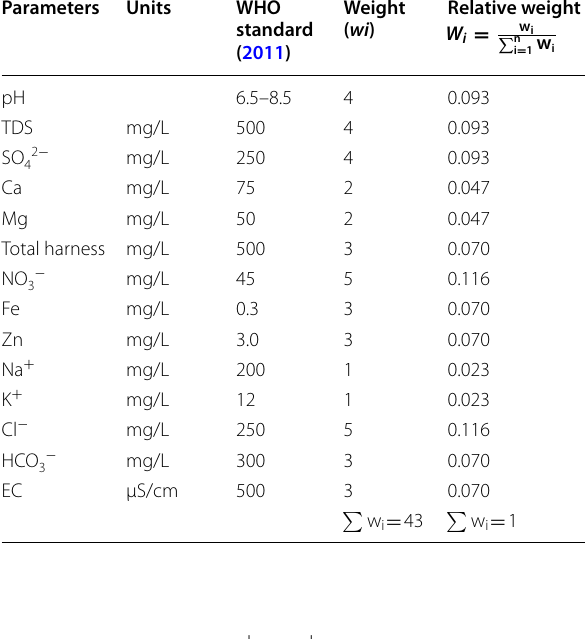
Table 2 Weights and relative weights of physiochemical